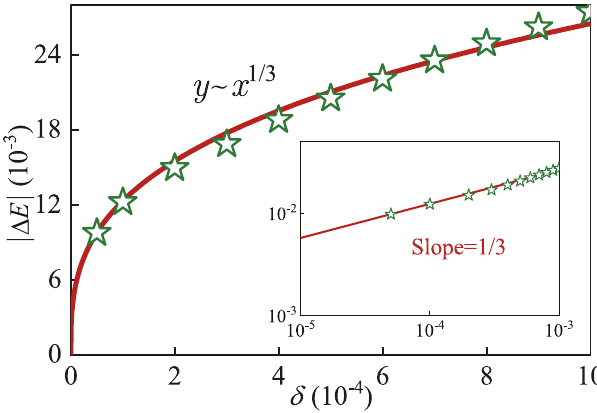
Fig. 4 Sensitivity of the designed metagrating at the third-order exceptional point (EP). Δ E on the y -axis represents the difference between real parts of the fi rst and second eigenvalues varying with the external perturbation δ , i.e., disturbances in c i (normalized imaginary part of the 2 sound speed in the second groove). The green stars represent the difference calculated by the coupled mode theory. Red solid line shows corresponding fi tting curves. The inset con fi rms the variation trajectory in the logarithmic